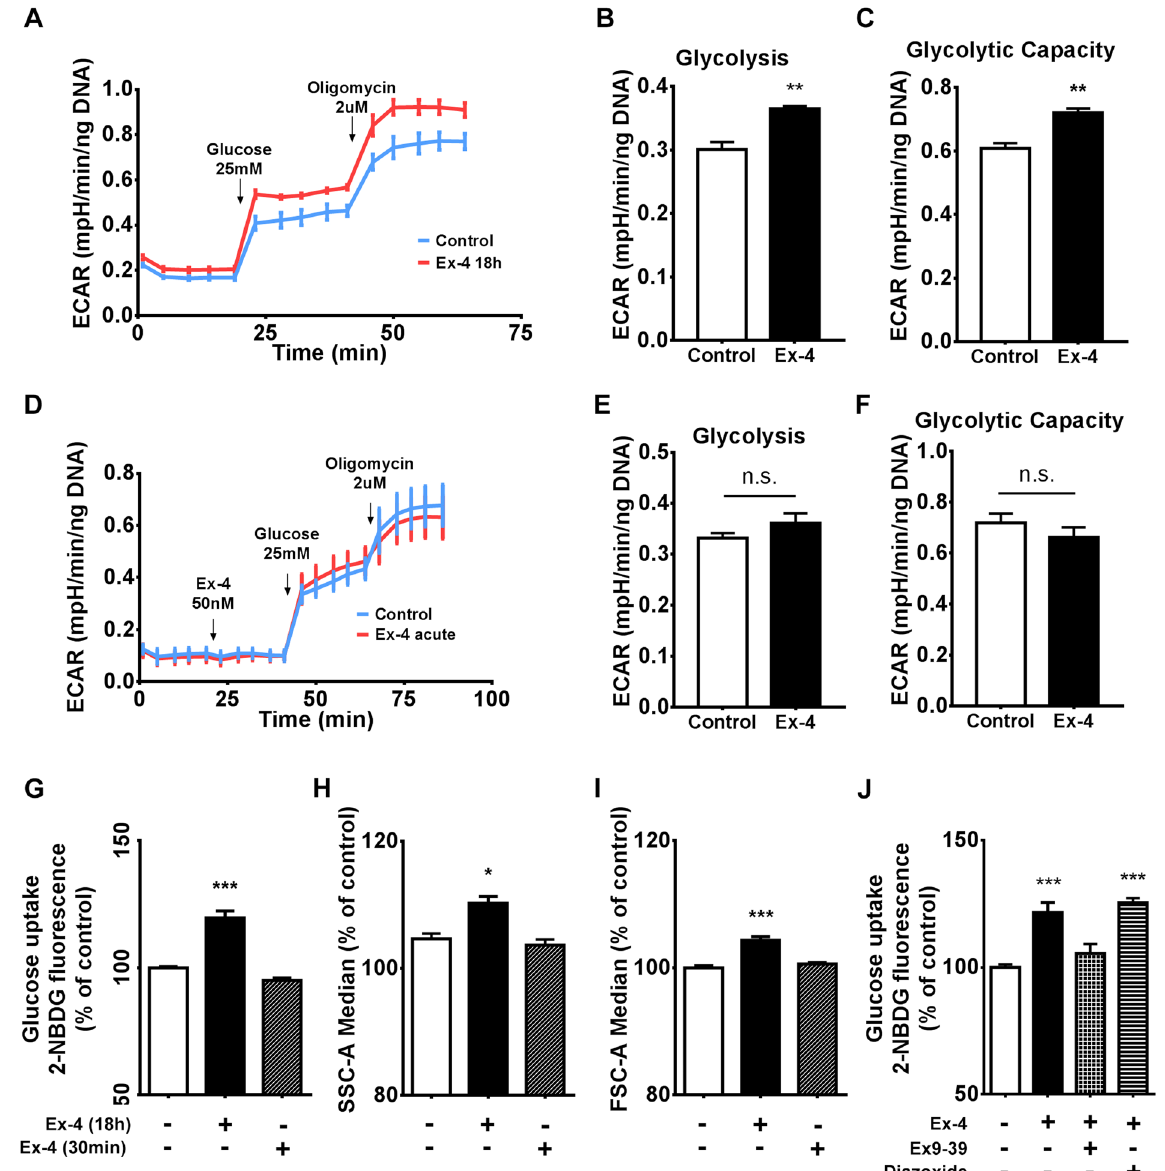
Figure 2. Prolonged, but not acute, Exendin-4 stimulation promotes metabolic reprogramming. Following 18 hours of incubation in the presence or absence of 50 nM Exendin-4, BRIN-BD11 cells were subjected to extracellular flux analysis. ( A ) ECAR was determined after sequential injection of 25 mM glucose and 2 µ M oligomycin. ( B and C ) Glycolytic rate and capacity were calculated as detailed in Methods. ( D ) ECAR profiles were generated using control untreated cells to evaluate the effect of acute injection of 50 nM Exendin-4 compared to cells injected with control media, followed by 25 mM glucose and 2 µ M oligomycin. ( E and F ) Glycolytic rate and capacity were calculated. ( G ) Uptake of 2-NBDG was determined by flow cytometry analysis after preconditioning in the presence or absence of 50 nM Exendin-4 for either 18 h or 30 min. ( H and I ) The same treatments were evaluated in respect to SSC-A and FSC-A to estimate cellular complexity and size respectively. ( J ) 2-NBDG uptake was determined after co-incubation for 18 h with 1 µ M Exendin (9–39) or 250 µ M diazoxide. Data represent mean ± SEM, n ≥ 3; n.s. = non-significant * P < 0.05; ** P < 0.01; *** P <